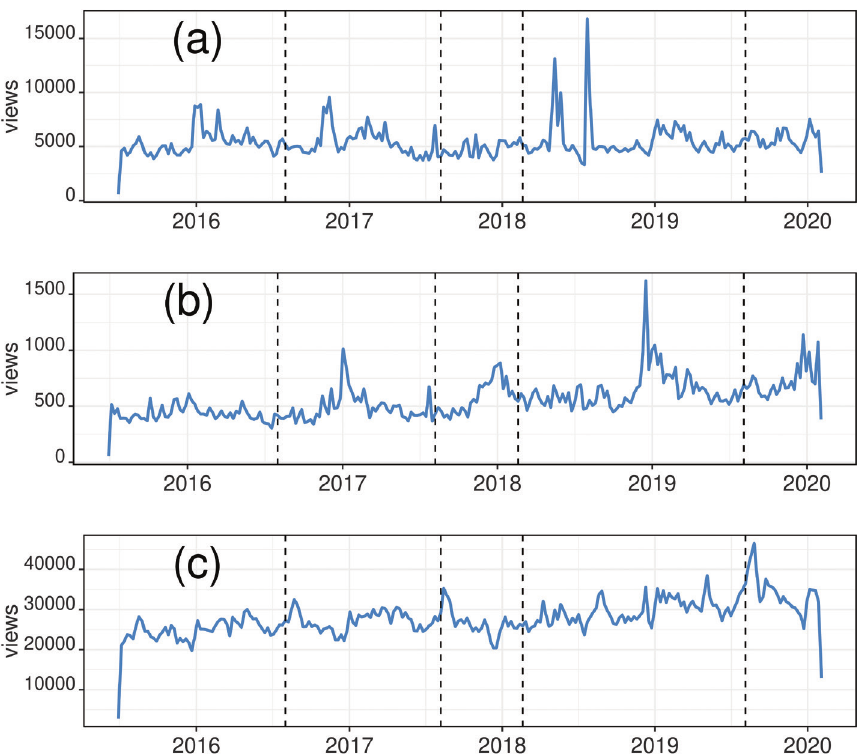
Figure 1. Number of visits to Wikipedia pages on invasive alien mammals included in the Union list (a), inva- sive alien mammals not included in the Union list (b) and native mammals (c). Dashed lines, from left to right, represent the publication of the first blacklist (July 2016), its first update (July 2017), the implementation of the first Italian law on invasive species (February 2018) and the second update of the blacklist (July